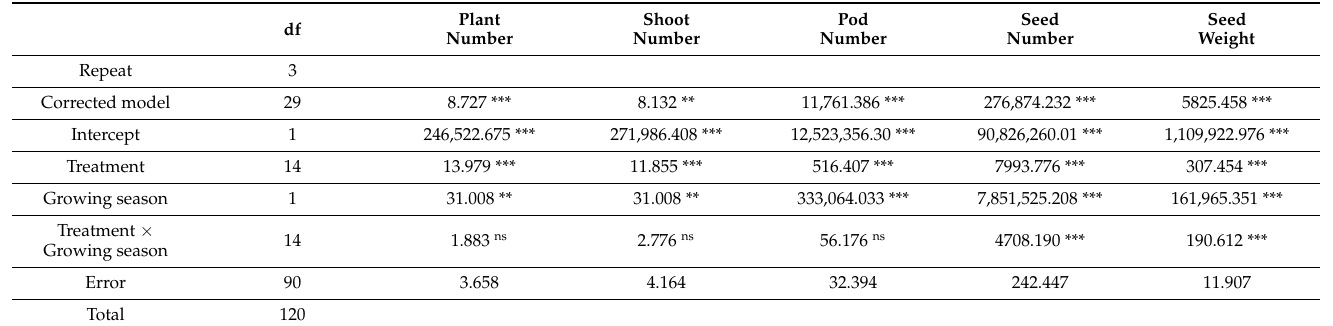
Table 10. Results of variance analysis of winter pea ( Pisum sativum L.) yield components